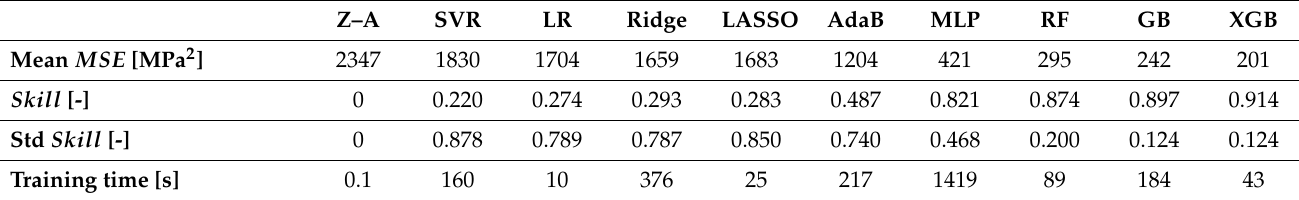
Table 3. Results obtained allowing for assessment of the considered